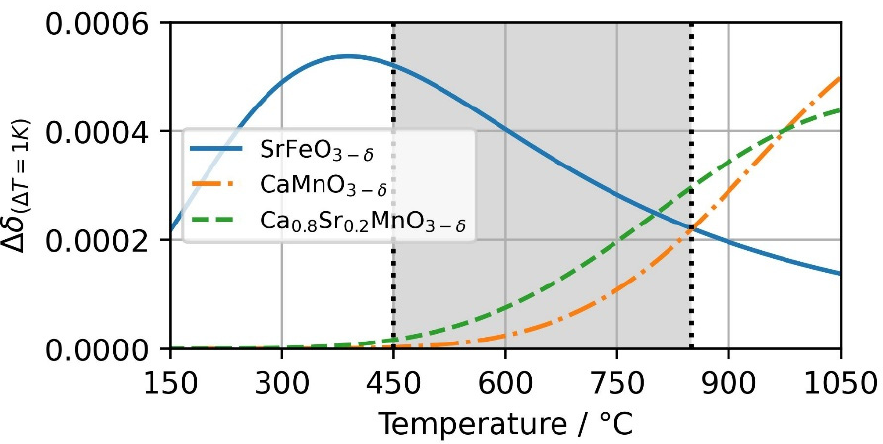
Figure 9. Change in non-stoichiometry ∆ δ based on temperature change of 1K at p O2 = 0.18 bar. The change of SrFeO 3 − δ , CaMnO 3 − δ and Ca 0.8 Sr 0.2 MnO 3 − δ is visualized over a temperature range from 150 to 1050 °C.